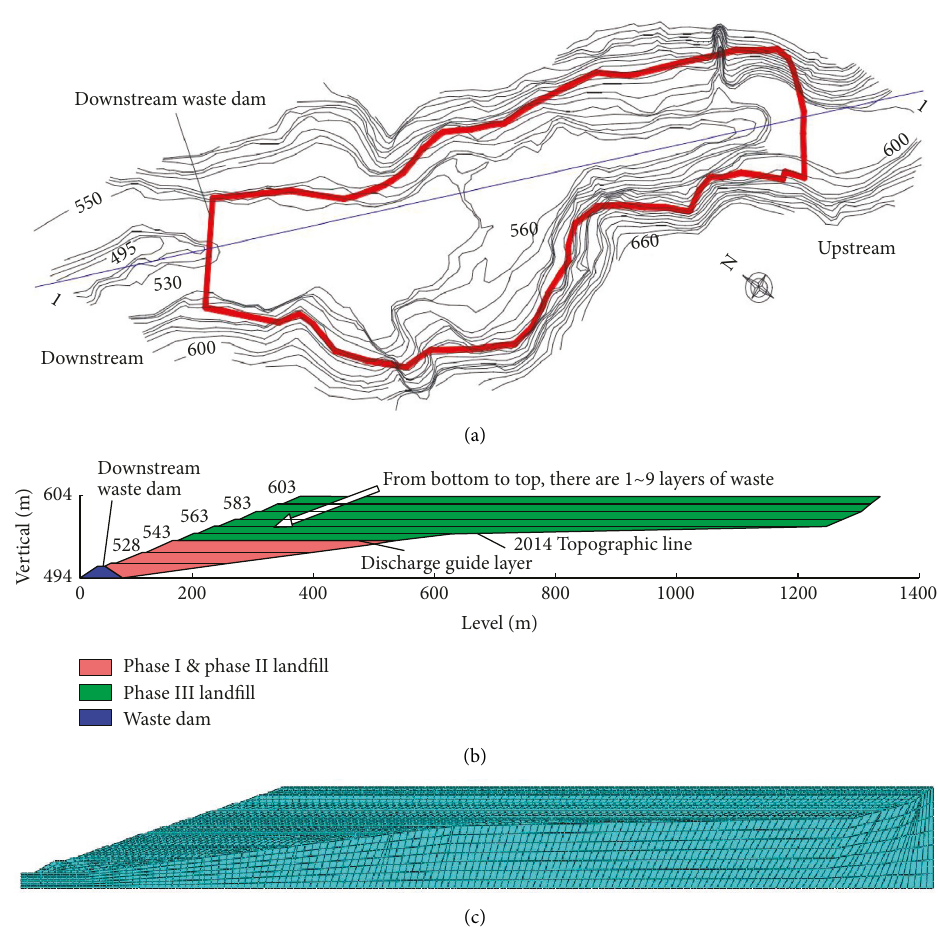
Figure 2: (a) Topographic chart of the landfill site. (b) Section 1-1 of the landfill. (c) Two-dimensional mesh model of the landfill.